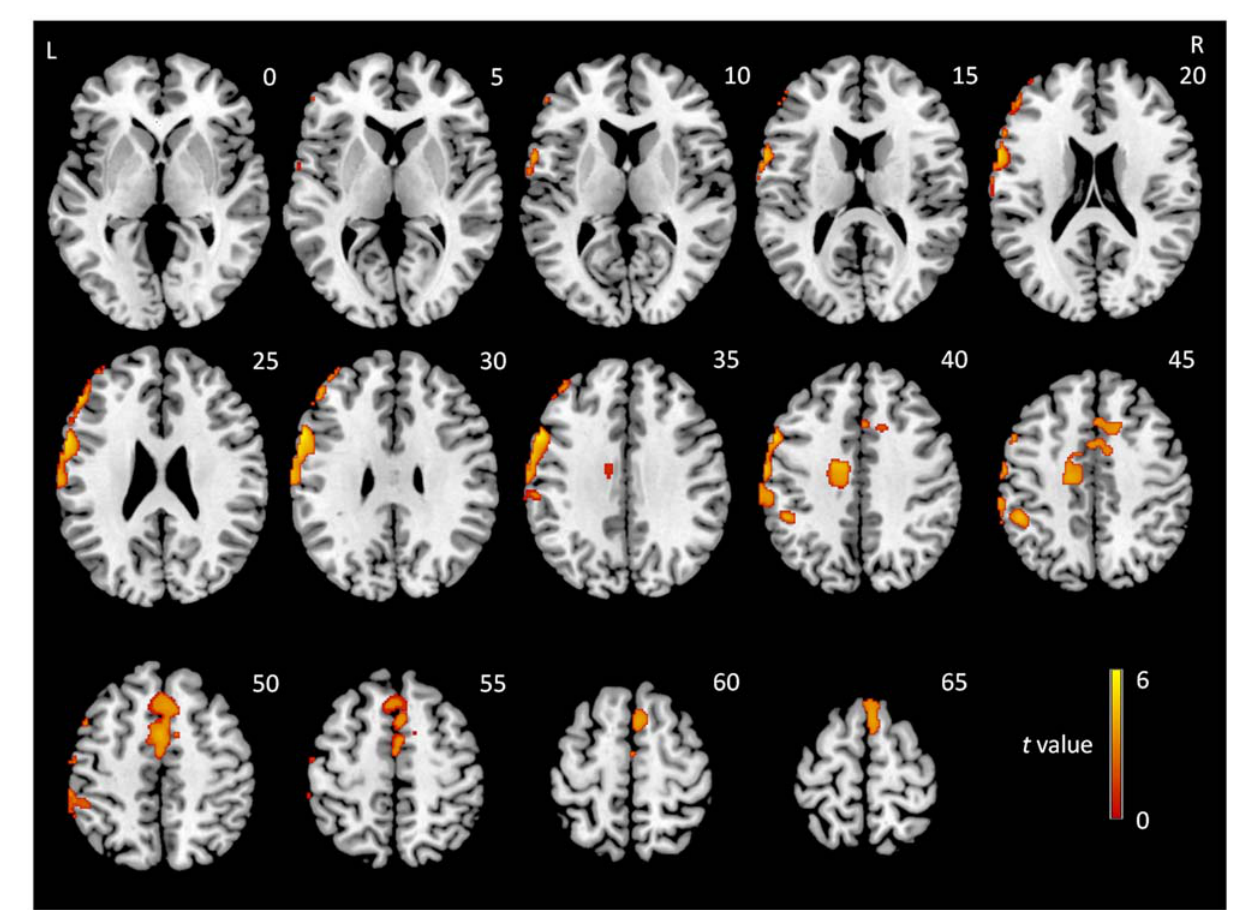
FIGURE 3 | t -Statistical difference maps in gray matter (GM) volume between MCI patients and normal controls (NCs). Results were obtained using a two-sample t -test. The color bar demonstrates t